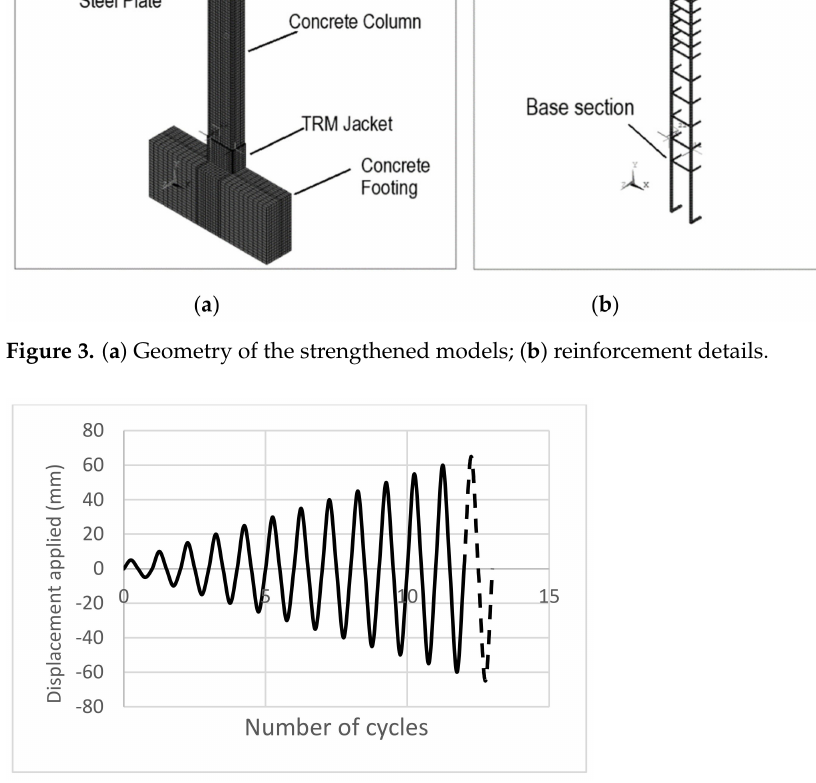
Figure 4. Representation of the cyclic displacement-controlled